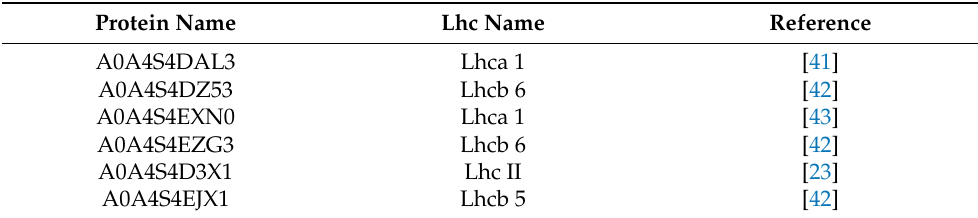
Table 3. Six detected differential proteins belonging to the chlorophyll a-b binding proteins family and related references.